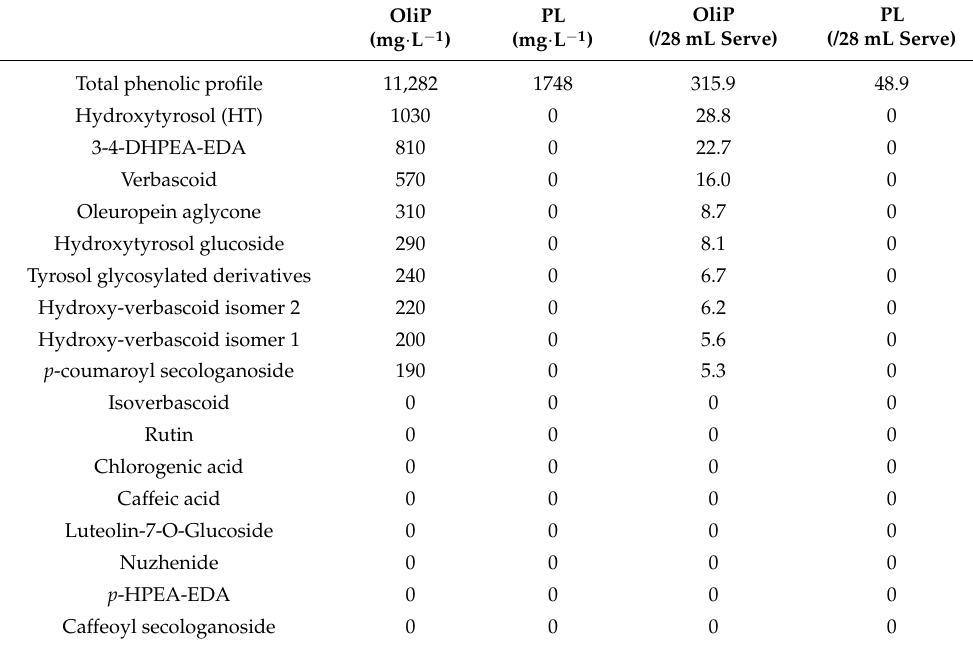
Table 1. Independent analysis of OliPhenolia ® (OliP) and placebo (PL)